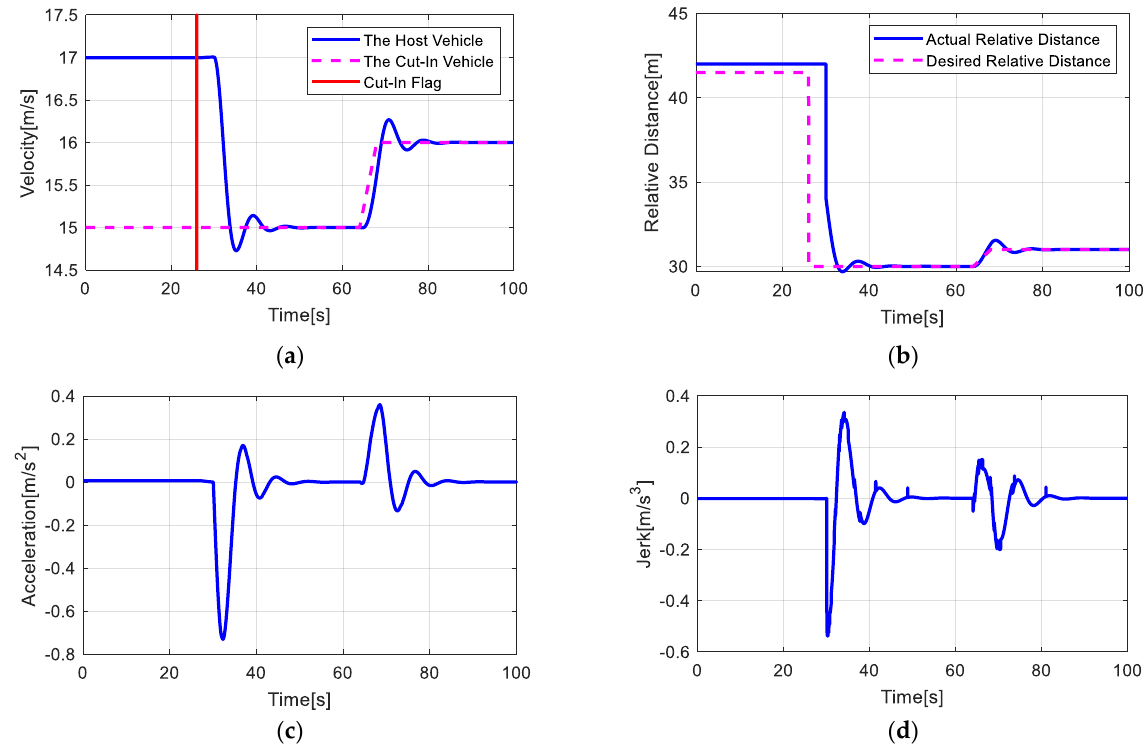
Table 1. Statistics of the acceleration and jerk of the host vehicle under driving scenario 1.